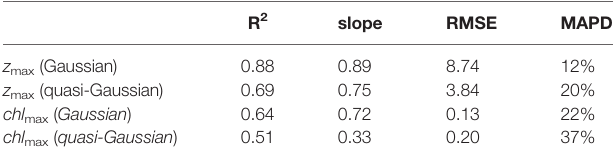
TABLE 3 | Accuracy of the Chl-a vertical pro fi le inversion model.